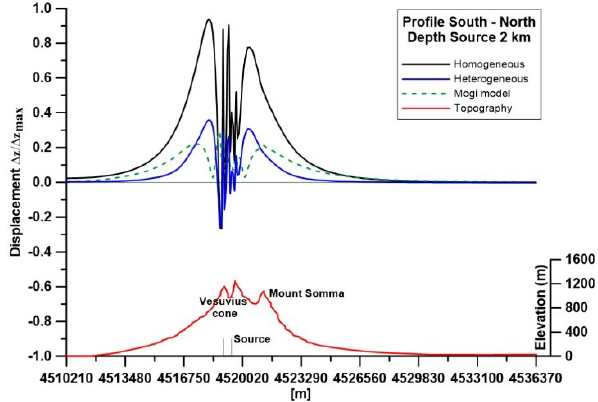
Figure 5. Normalized vertical displacements for homogeneous, het- erogeneous cases and Mogi model, which does not take into account the topography, along South-North profile.